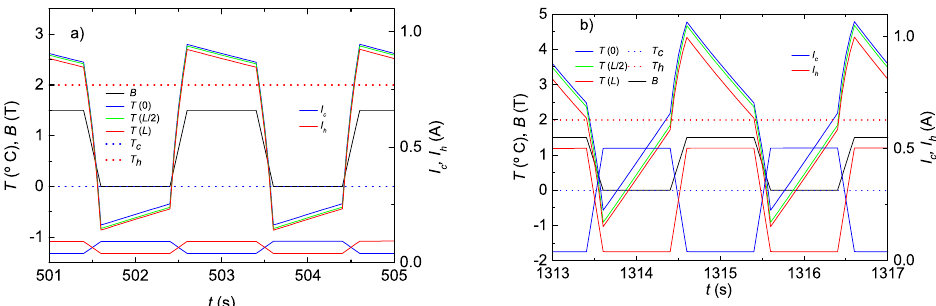
Figure 7. ( a ): Magnetic field B ( t ) and temperatures at three points of the MCM for low and equal currents at the TE cells. Temperatures of the cold source T c and the hot sink T h . Currents at the TE cells, I c ( t ) , I h ( t ) . The current amplitudes are slowly increasing with time. ( b ): Same variables for higher currents, I c = I h (cid:39) 0.5